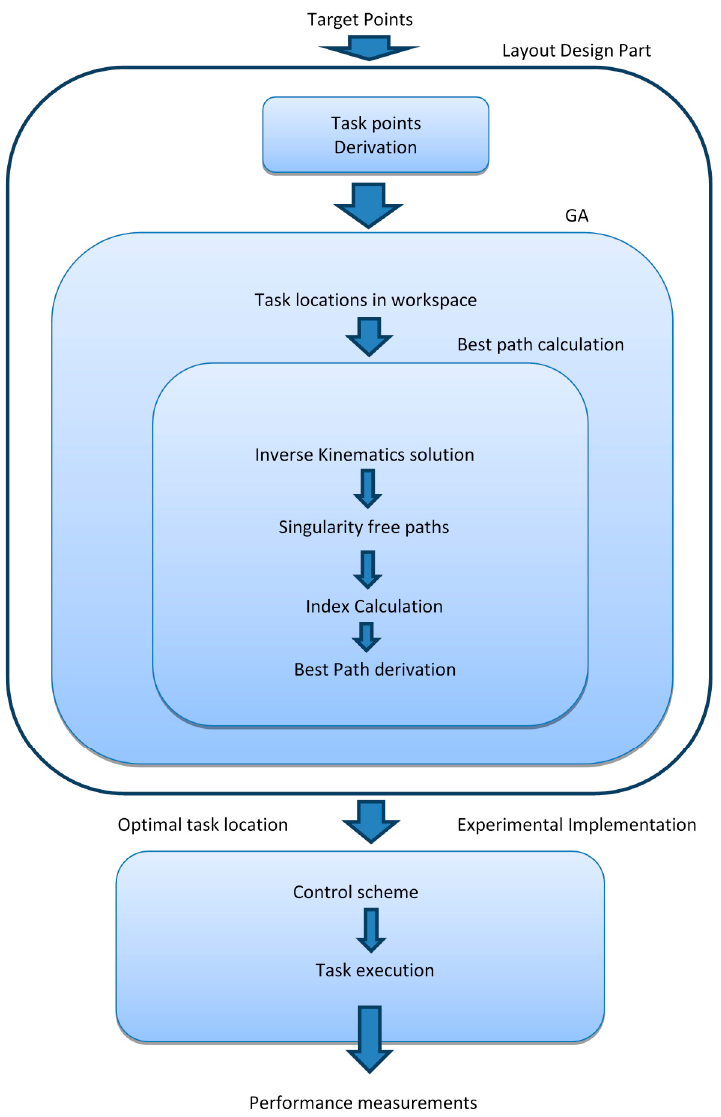
Figure 1. Process of the proposed method realization.